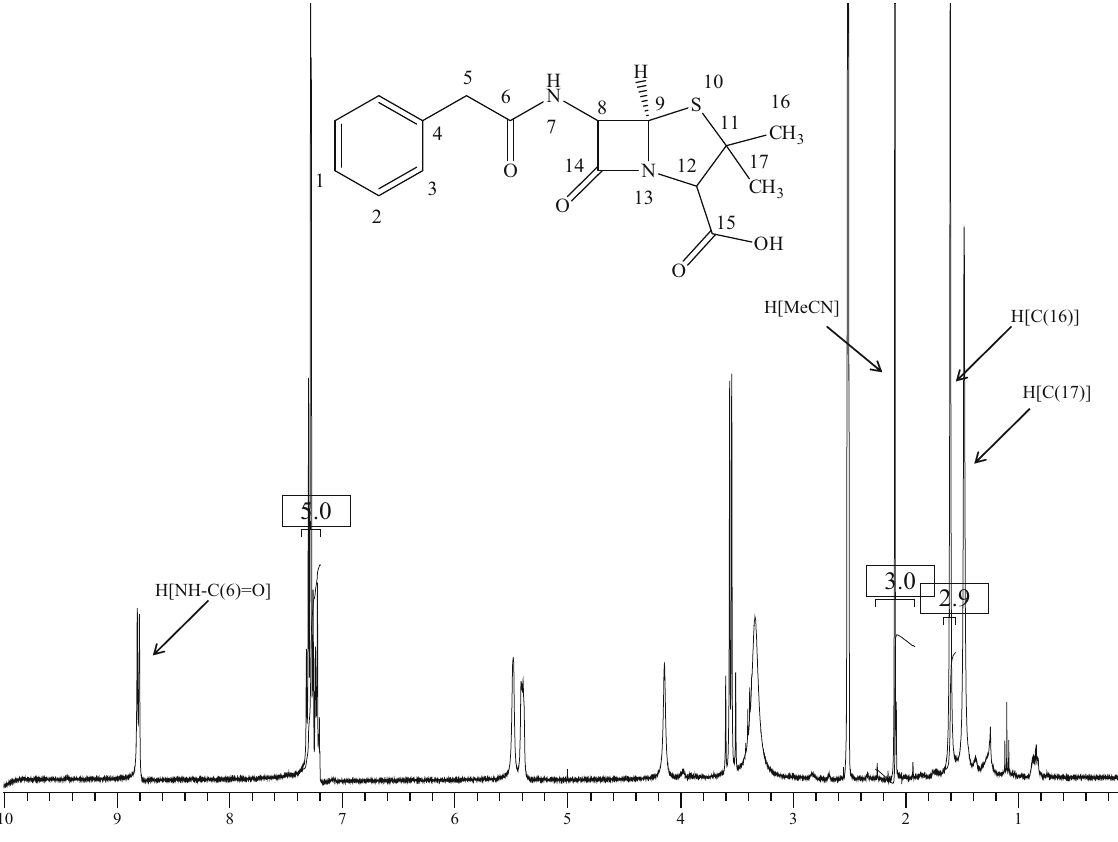
Figure 4: 1 H - NMR spectra of PenAcAg in DMSO - d 6